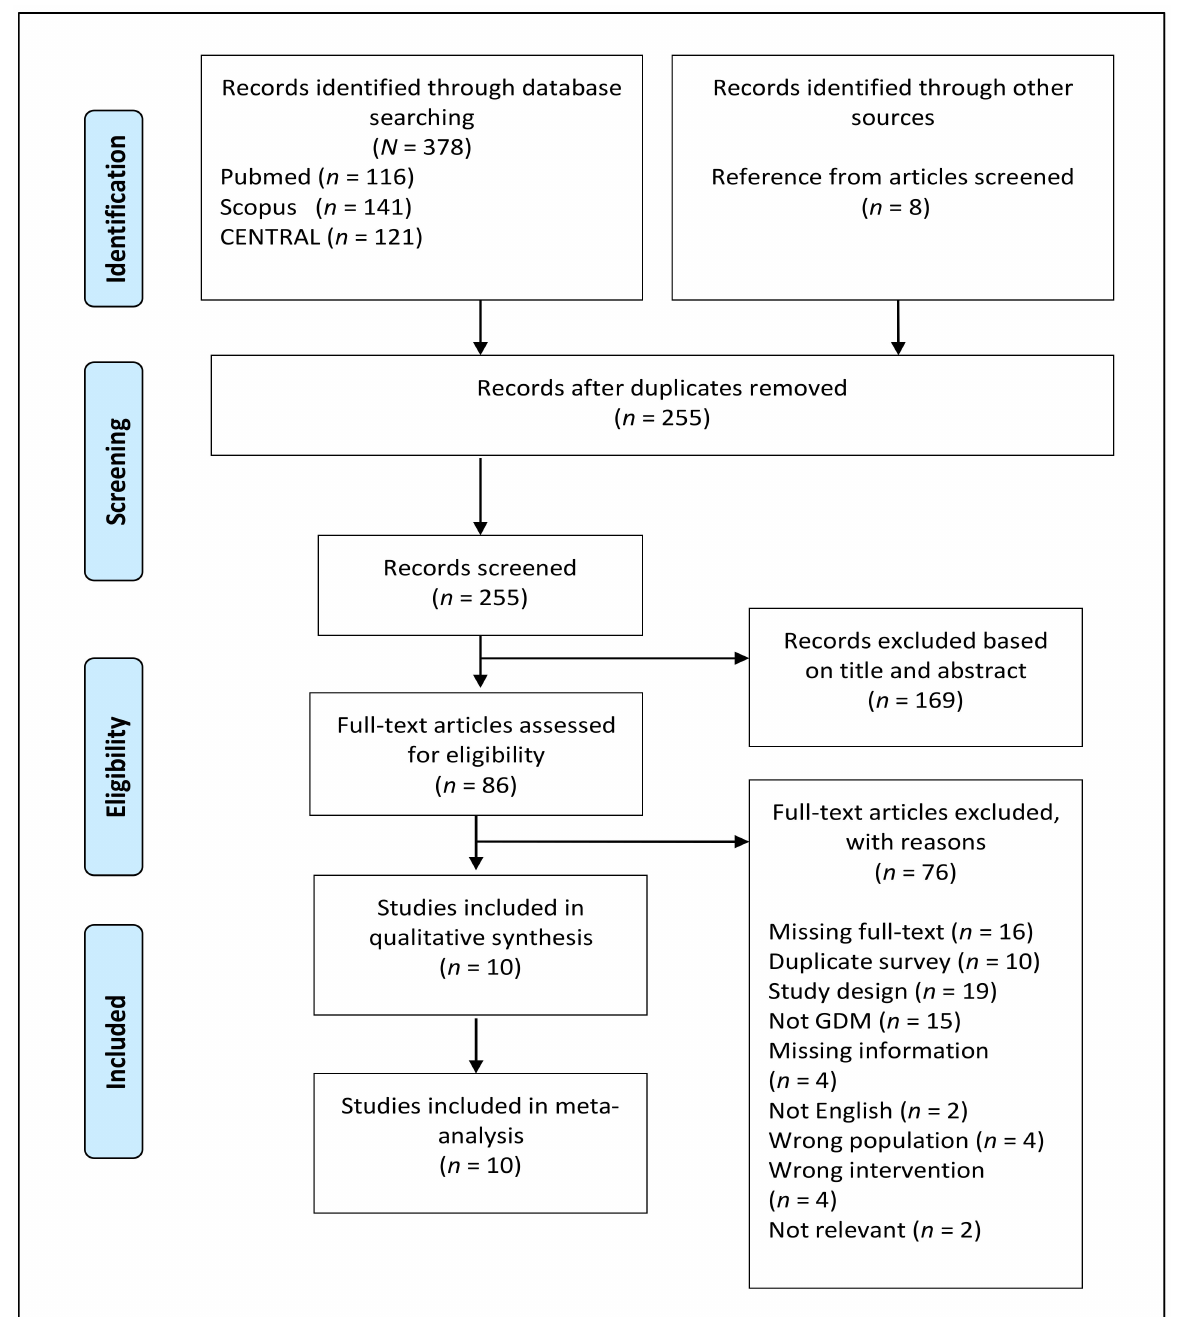
Figure 1. PRISMA flowchart for search strategy and study selection